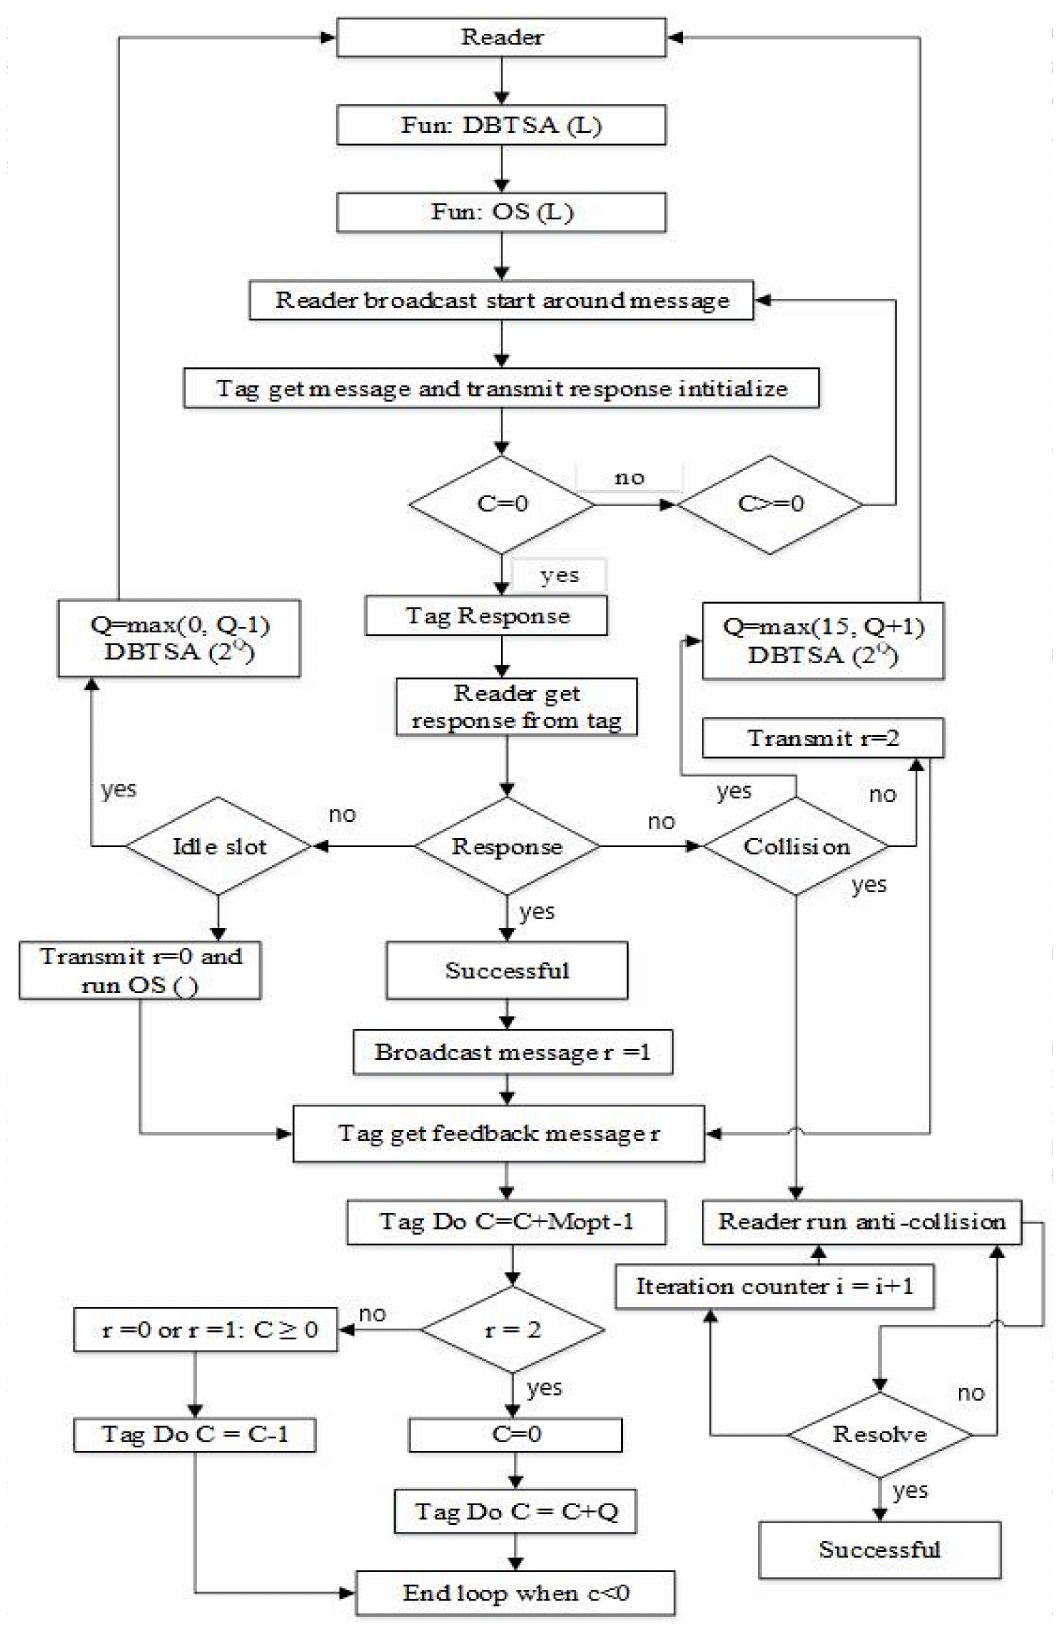
Figure 5. Flowchart of the proposed DAF-OS